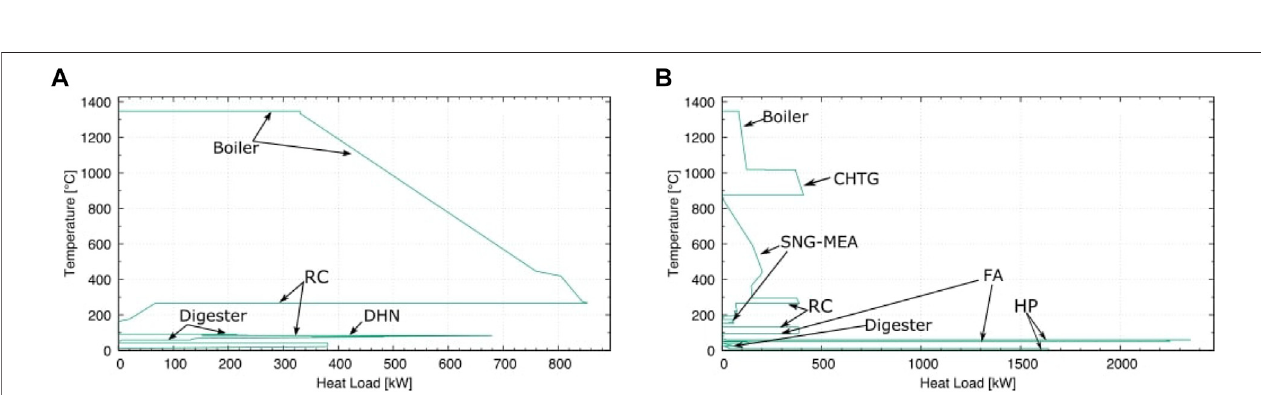
FIGURE6| Grandcompositecurves(GCC)of (A) referencecase(noinvestment)and (B) maximumaverageinvestment.GCCareagraphicalrepresentationofthe heat cascade, showing the excess heat availability at each temperature interval. RC - Rankine cycle, HP - heat pumps, DHN - district heating network, FA - formic acid production.